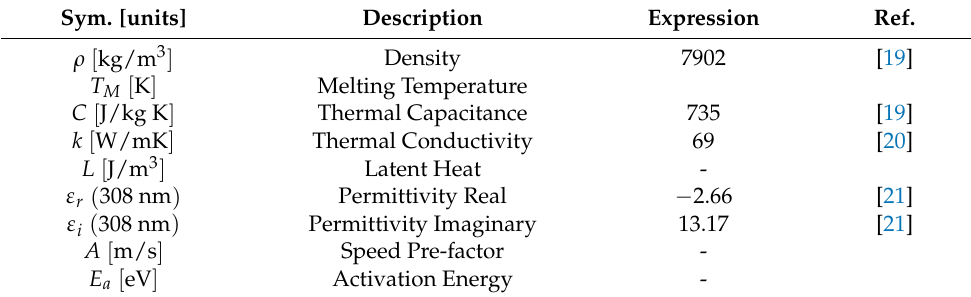
Table 2. Ni liquid material calibration parameters.